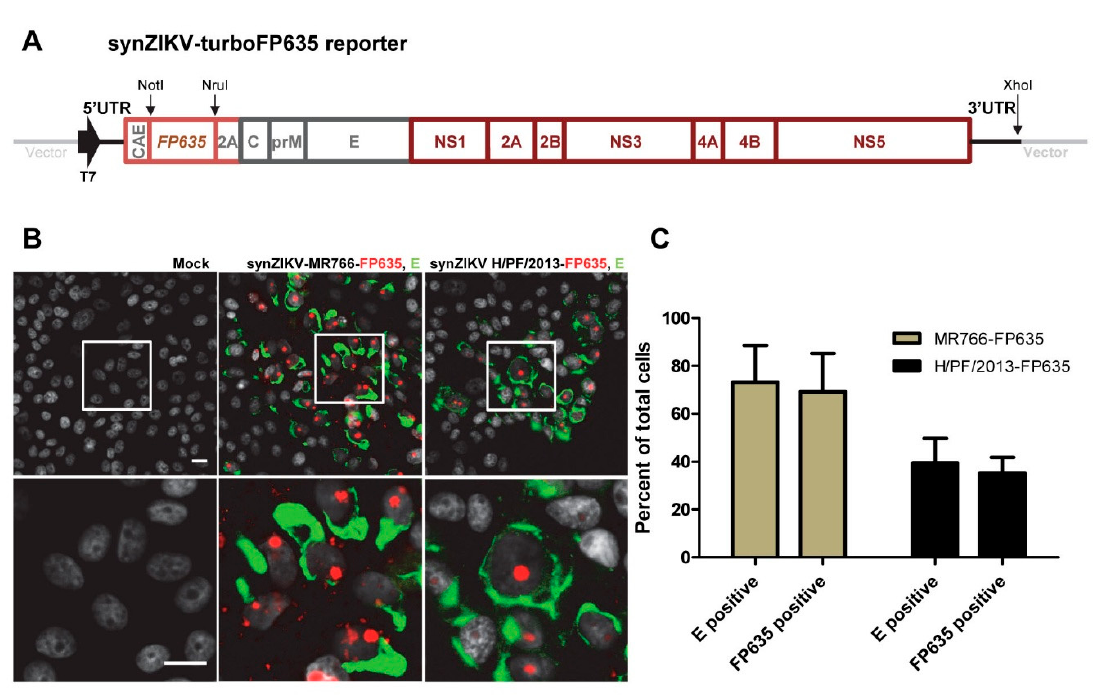
Figure 4. Construction and characterization of synZIKV-FP635 reporter viruses suitable for live cell imaging. ( A ) Schematic representation of the synZIKV-FP635 reporter genomes. The FP635 gene fused at the 3 ′ end to the coding sequence of the SV40 NLS (not indicated) was inserted into the synZIKV constructs via NotI/NruI restriction sites. ( B ) Detection of E-antigen by immunofluorescence analysis of VeroE6 cells 96 h post-transfection with synZIKV-FP635 RNAs. The FP635 signal (red) was detected by its fluorescence. Note the accumulation of FP635 in distinct nuclear sites, most likely corresponding to nucleoli. Nuclear DNA was counterstained with DAPI (grey). Scale bar = 15 μ m. ( C ) Quantification of E- and FP635-positive VeroE6 cells 96 h post-transfection of synZIKV-FP635 RNAs. Results show the mean from two independent experiments ± SEM. At least 150 cells per condition were counted.